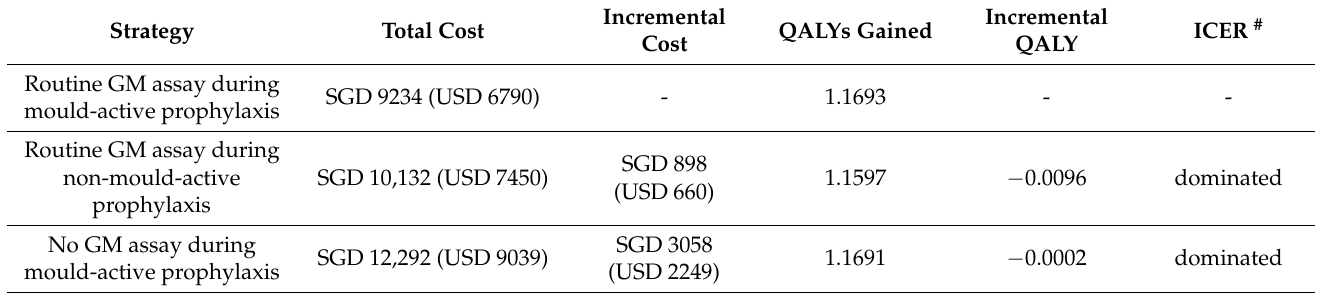
Table 3. Total cost, effectiveness, and incremental cost-effectiveness ratio of various prophylaxis-biomarker strategies in the 60-year-old